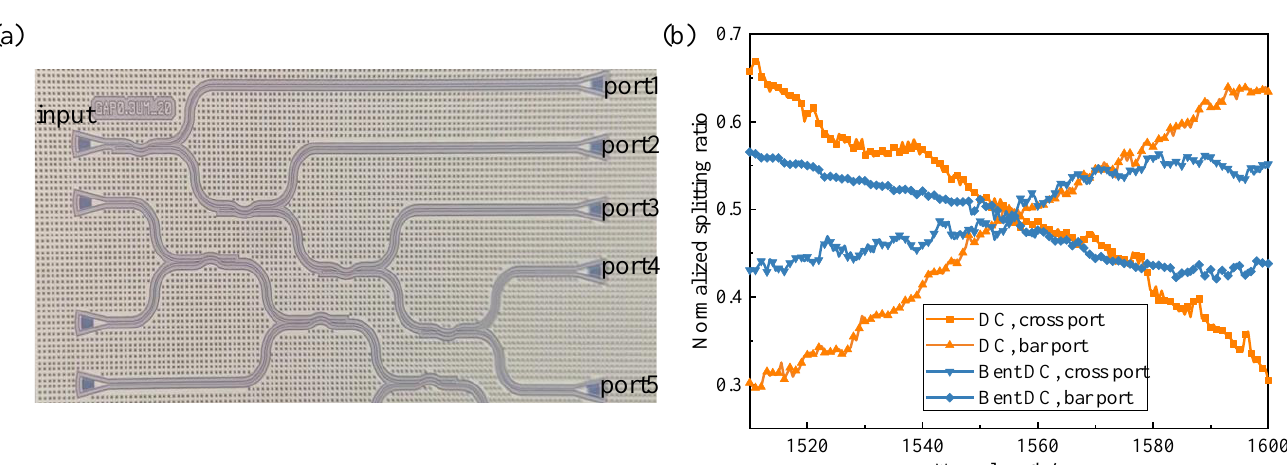
Figure 6. ( a ) The test structure of the bent DC; ( b ) the measured transmission spectra of the conven- tional DC and the bent DC.